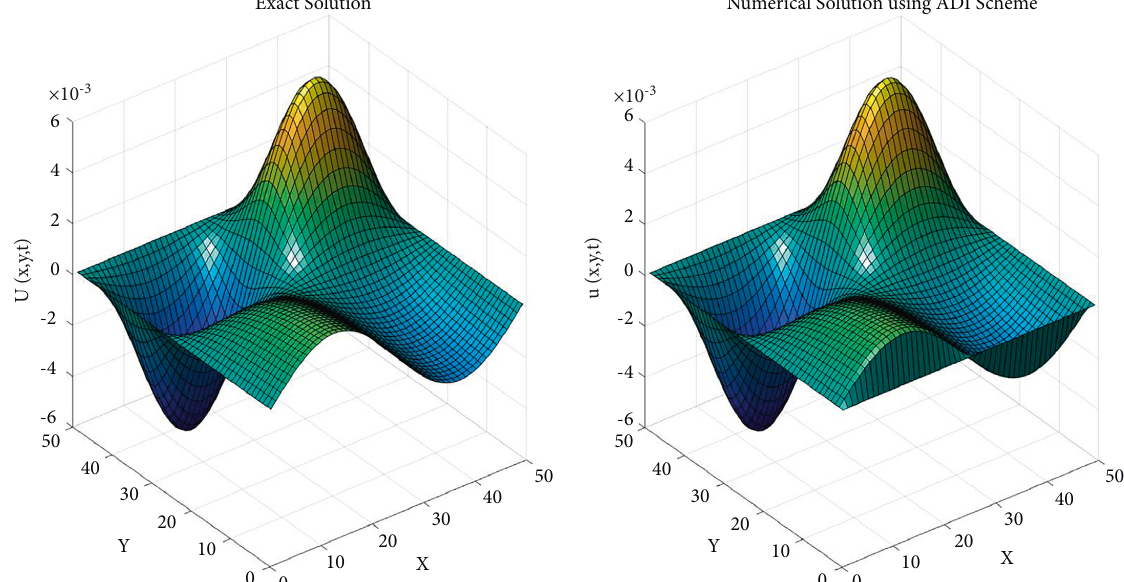
Figure 8: Analytical and approximate results of ADI at 75 × 75 grid size, time step � 0 . 001, and ϵ � 0 . 01.